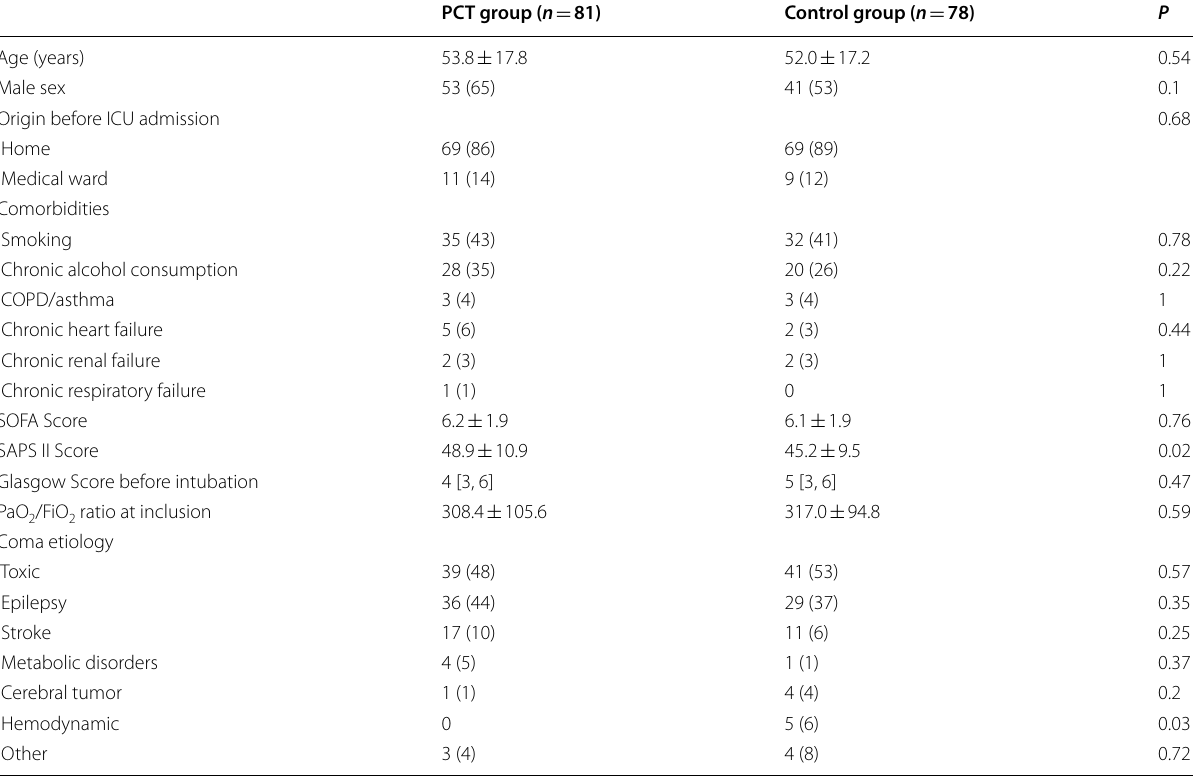
Table 1 Baseline characteristics of the study population, by group